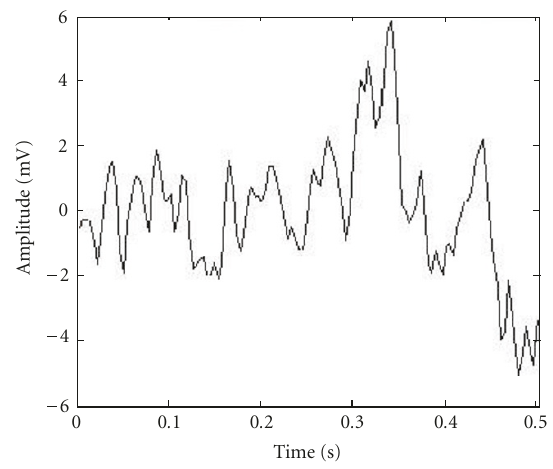
Figure 16: Auditory P300 obtained using CBSS.